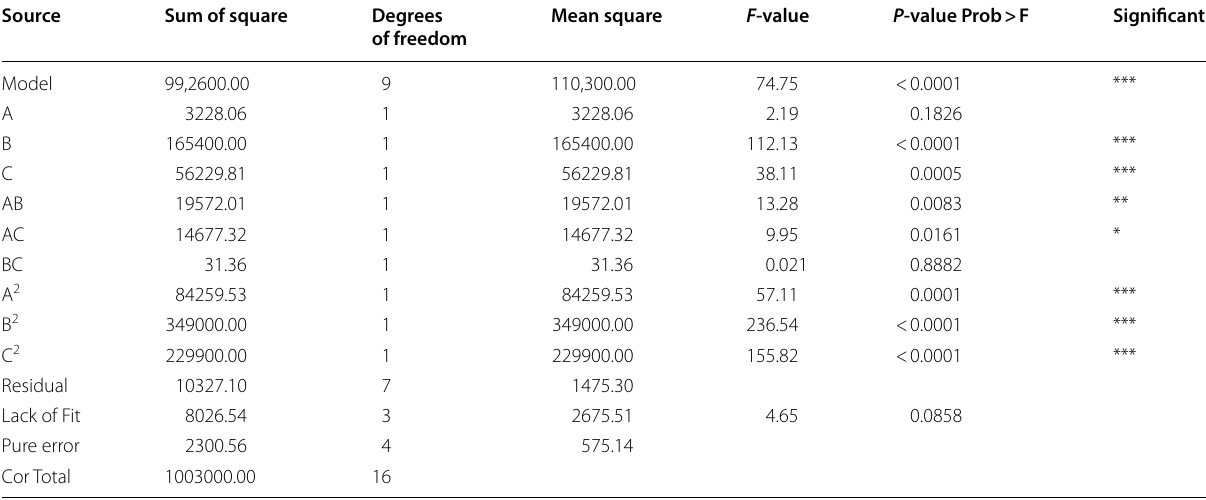
Table 3 ANOVA for response surface quadratic